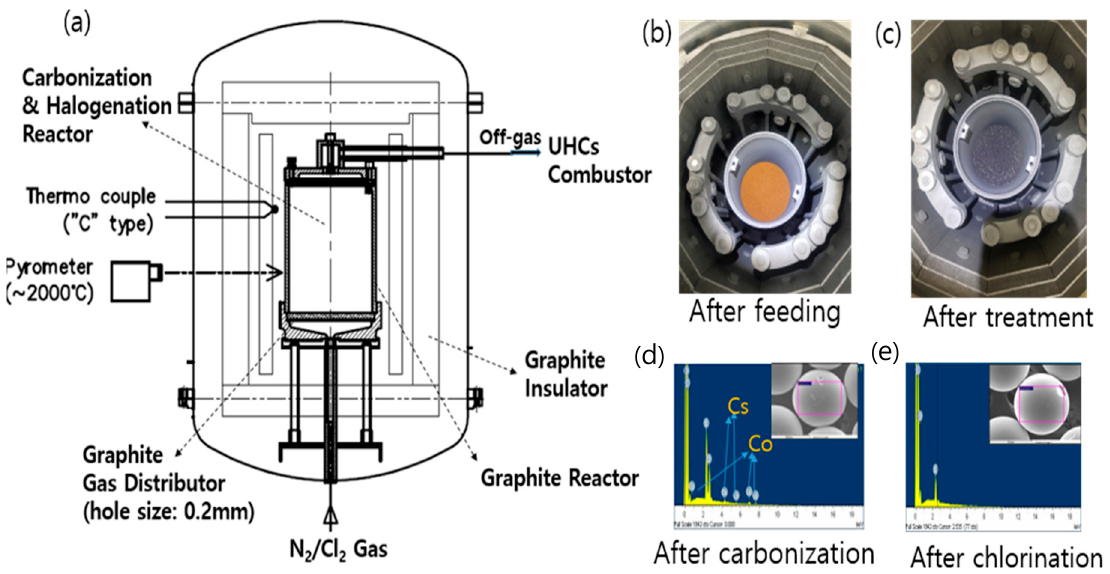
Figure 15. Detailed design of the multifunctional reactor implementing carbonization of CER ( a ), pictures of the reactor after the feeding of the CER ( b ) and after the treatment ( c ), and the SEM-EDS results of the carbonized CER ( d ) and chlorination-treated carbonized CER ( e ).